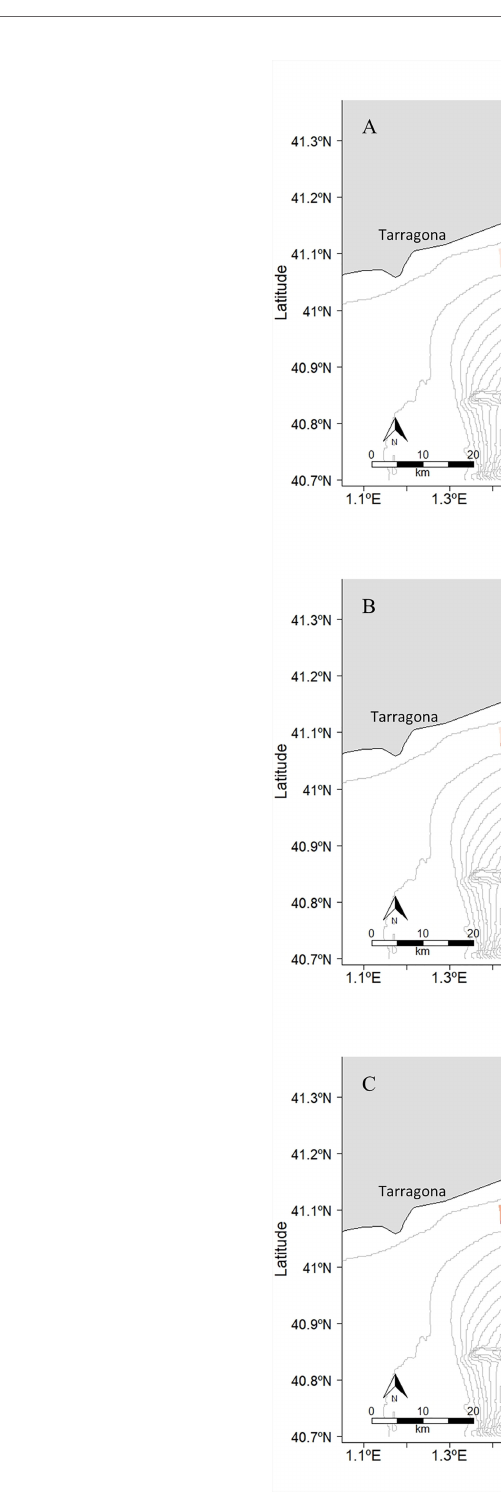
FIGURE 8 | Vessel route density maps within the study area in 2021. The fi rst map (A) represents the cargo ship route density in May, the second (B) represents the tanker ship route density in March and the third (C) one represents the passenger ship route density in May. These maps represent the months with highest marine traf fi c for each type of vessel. The maps of the months left can be found in the Supplementary Figures S29-S31